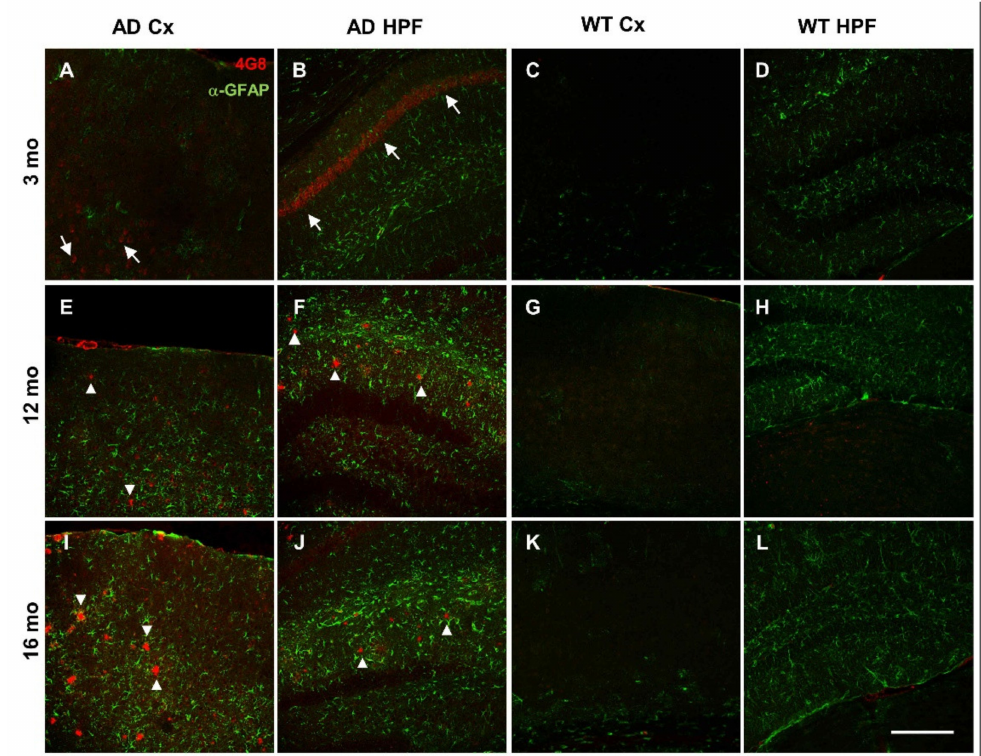
Figure 2. Plaque deposition and astrogliosis increase in AD mice with age. ( A – L ) Representative confocal images of immunostaining for APP/A β with 4G8 (red) and for astrogliosis with anti-GFAP (green) antibodies, of cortical (Cx) and hippocampal (HPF) regions from coronal slices of 3- ( A – D ), 12- ( E – H ), and 16- ( I – L ) month-old AD and WT mice (20x, scale bar, 200 µ m). Arrows indicate 4G8 intraneuronal staining; arrowheads indicate 4G8 staining of A β plaques. Confocal images of the entire slices are shown in Supplementary Figure S2 with quantification in Supplementary Figure